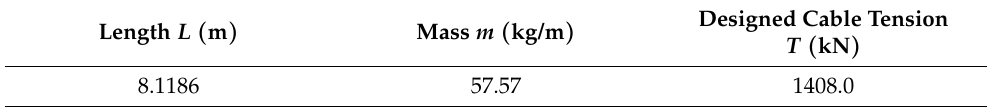
Table 2. Parameters of experimental cable.